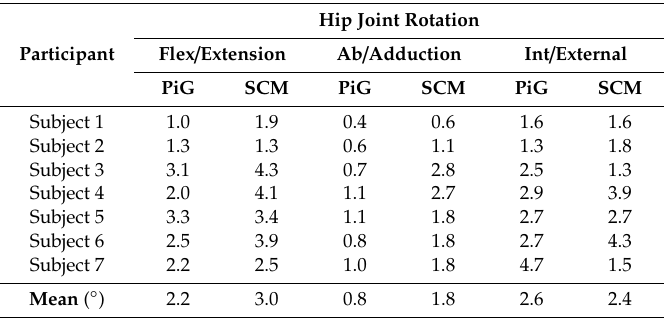
Table 2. Within-subject variability of hip joint rotation over the sound gait cycle across three trials per participant as calculated by PiG and SCM is shown by the standard deviation, SD.